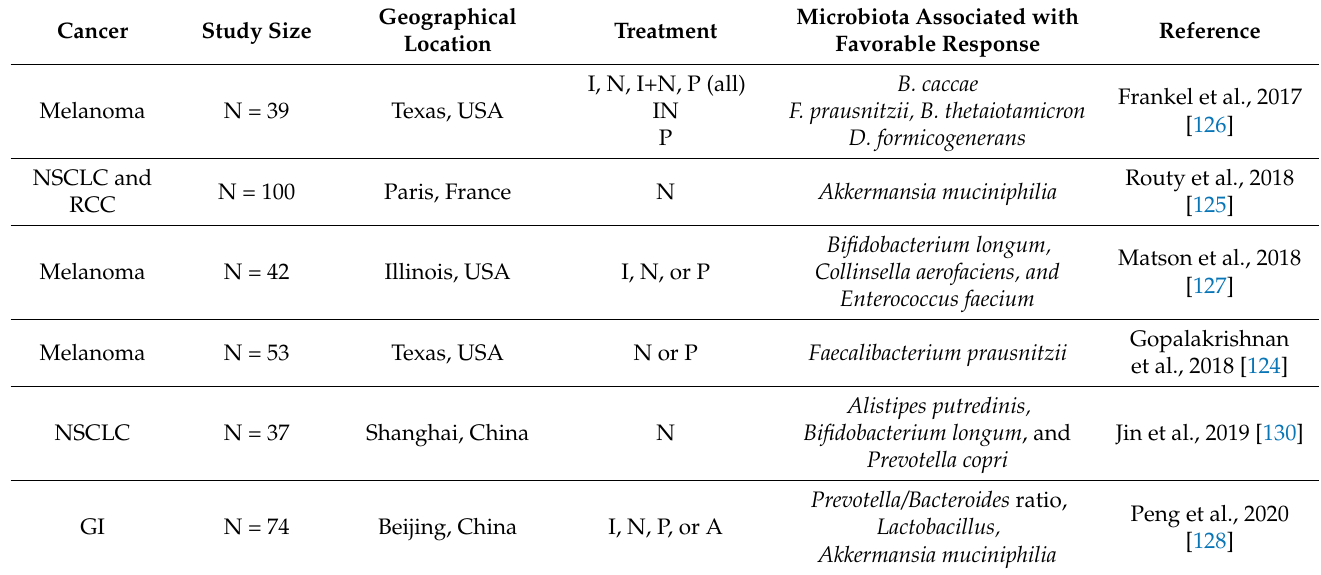
Table 1. Clinical studies investigating gut microbiome correlations with immune checkpoint blockade therapy responsiveness. Cancers: NSCLC: non-small cell lung carcinoma, RCC: renal cell